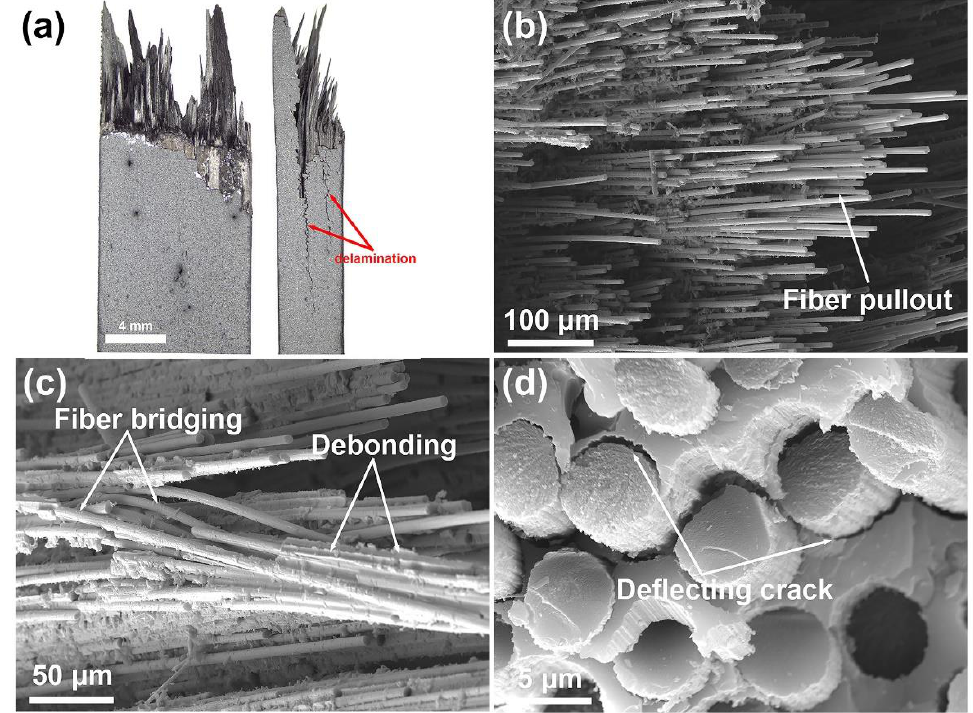
Figure 9. ( a ) Typical optical microscope images of the fracture morphology of the C f /SiC–Al 2 O 3 composite; and ( b – d ) secondary electron SEM images of the fracture morphology of the C f /SiC–Al 2 O 3 composite after bending test.